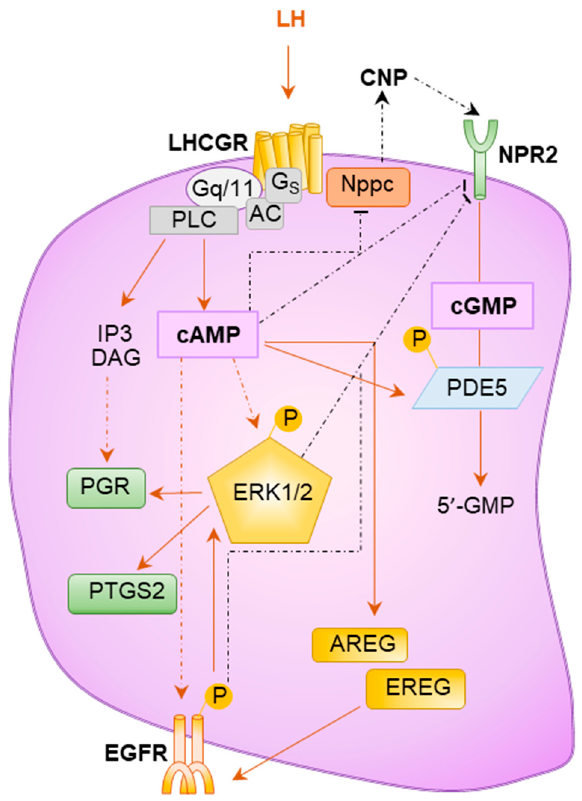
Figure 4. LH signaling in the ovarian follicles. The final stages of follicle maturation and ovulation are dependent on binding of LH to the LHCGR in mural granulosa cells (GCs). The binding of LH